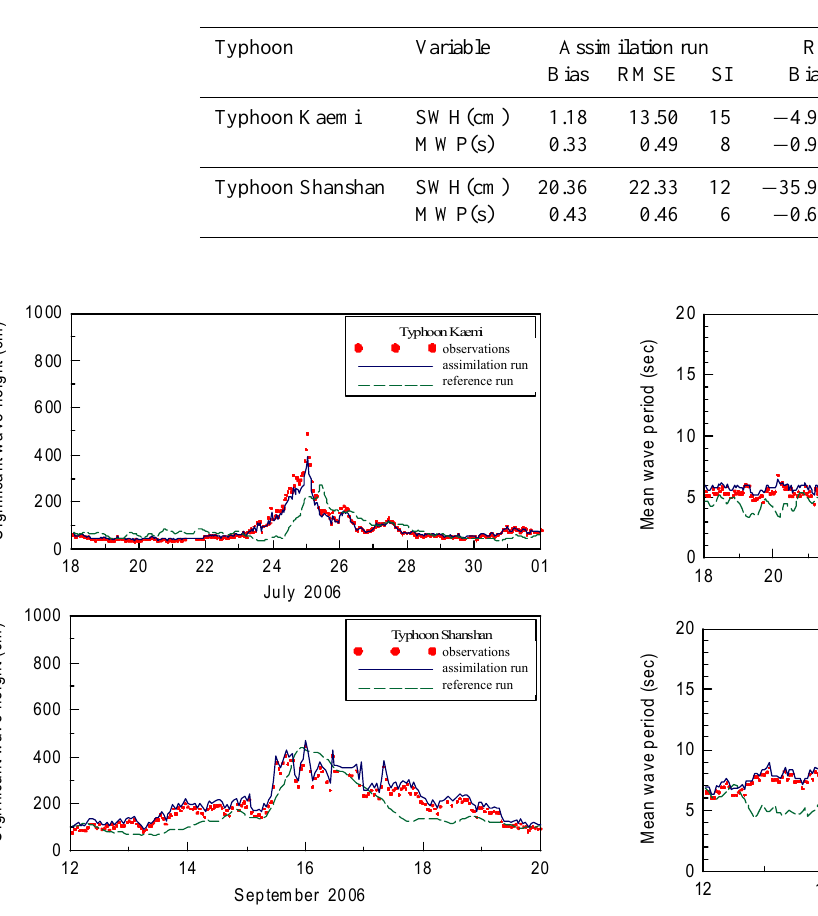
Fig. 4. Spectra at the Hualien buoy on 24 July 2006 at 05:00UTC and on 15 September 2006 at 15:00UTC. Fig. 4: Spectra at the Hualien buoy on 24 July 2006 at 0500 UTC and on 15 September 2006 Table 4. Statistical results of the comparison between the model results and independent observations at the Hualien buoy station: bias, root at 1500 UTC. mean square error (RMSE), and SI.